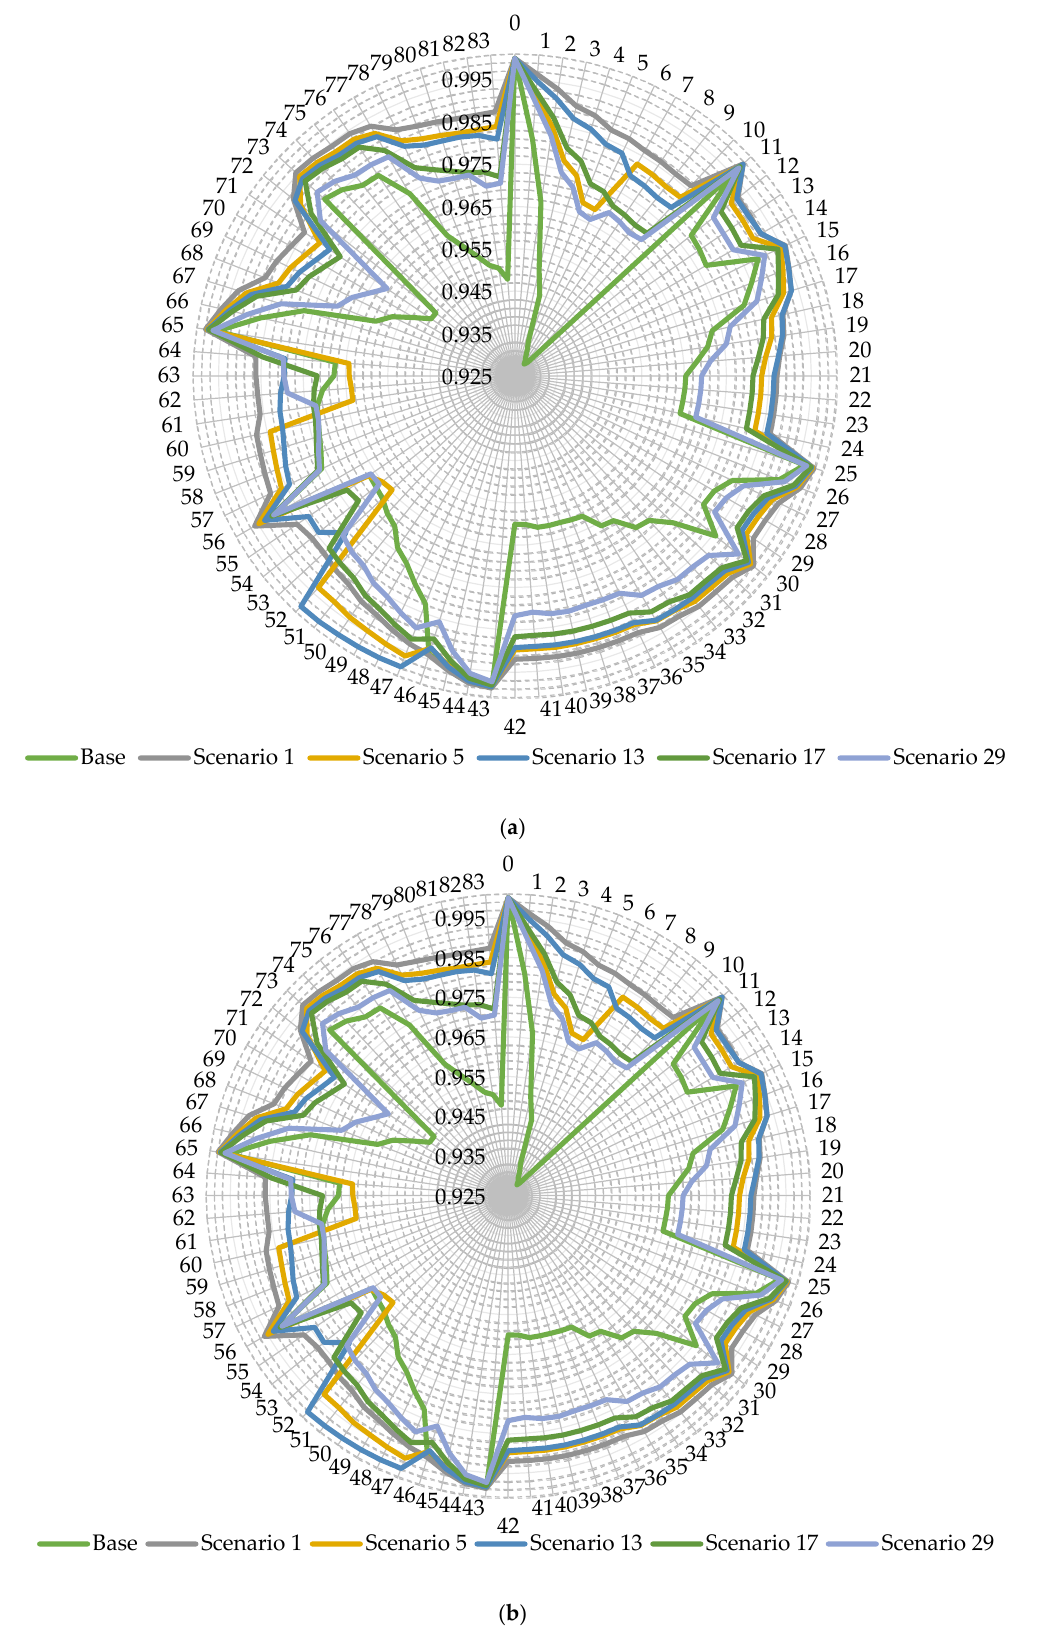
Figure 16. |𝑉 𝑘,𝑠 | at multiple scenarios for the 83-node distribution network: ( a ) Via NSGA-II, and ( b ) Via MOPSO.